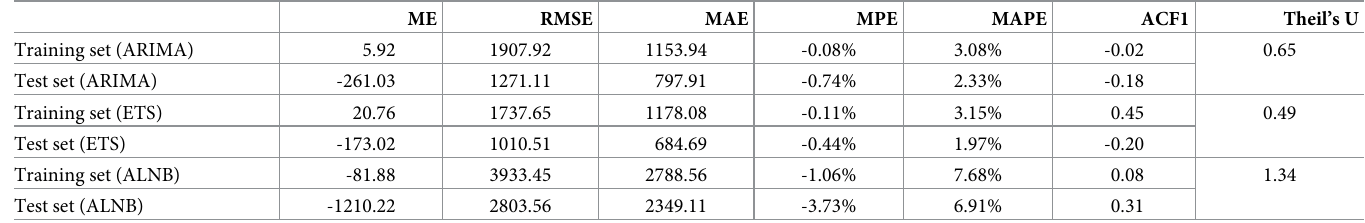
Table 4. Accuracy measures of the models based on a split in training set (January 2015 to February 2019) and test sets (March 2019 to December 2019) for the Spanish